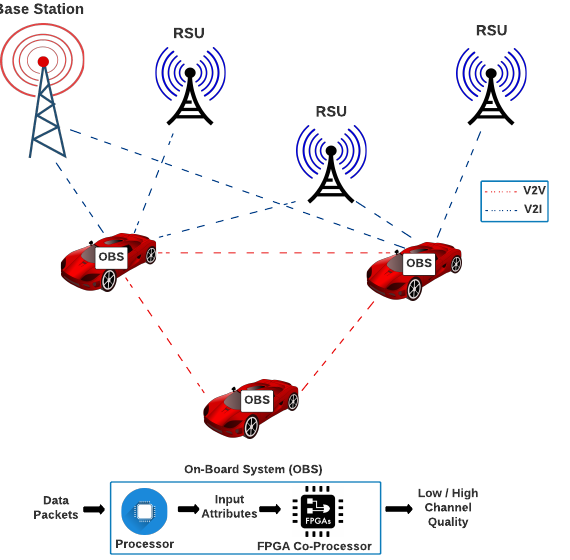
Figure 3. System model to implement in V2V and V2I Communications our proposal as part of an On-Board